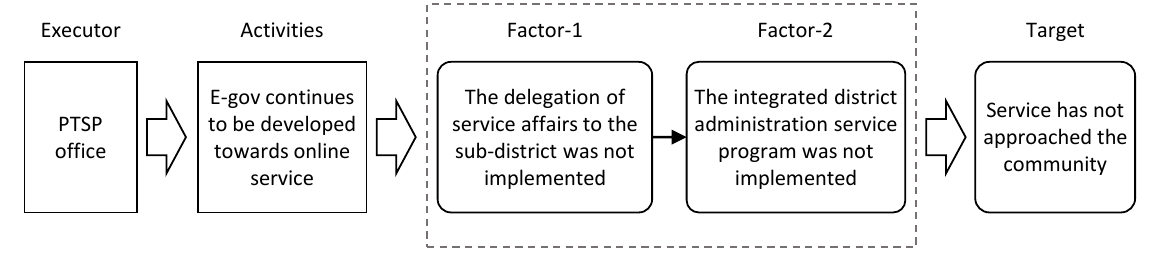
Figure 2. Actual service delivery model of one-stop integrated services/OSS in